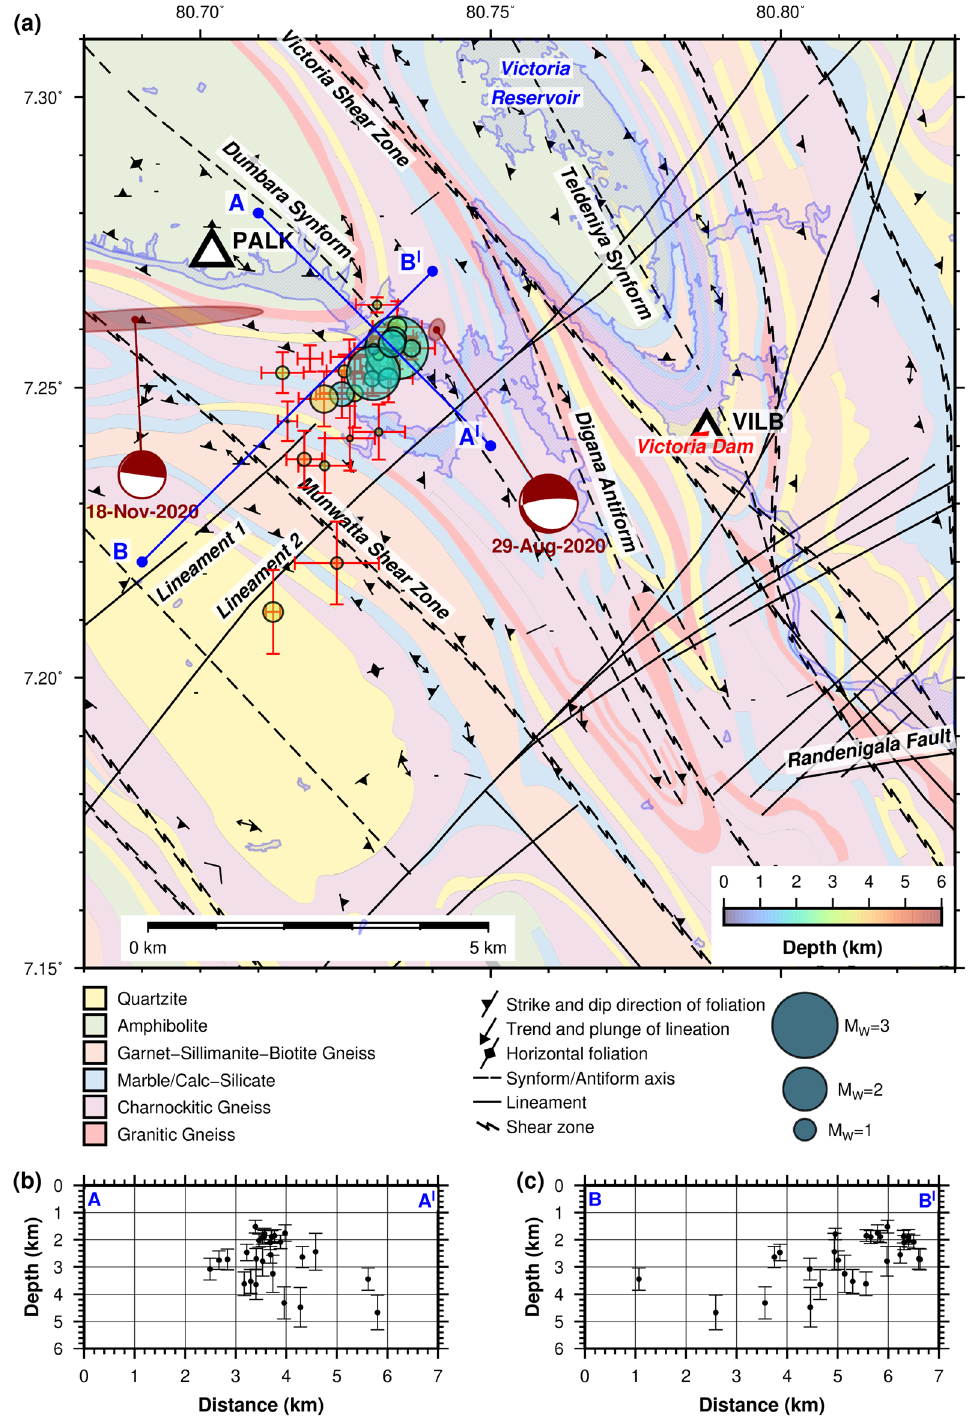
Figure 2. Centroids of the seismic swarm and the geology and structure of the area. ( a ) Epicentres of earthquakes. Error bars (red) indicate the standard deviation in the epicentre estimates from the single station method. Red ellipses indicate the error ellipses of the epicentres of the two earthquakes on 29 August and 18 November 2020 from travel-time inversion. ( b ) Profile along AA I . ( c ) Profile along BB I . Error bars in ( b ) and ( c ) indicate standard deviation in depth estimates from the single-station method. Figure compiled using Generic Mapping Tools 61